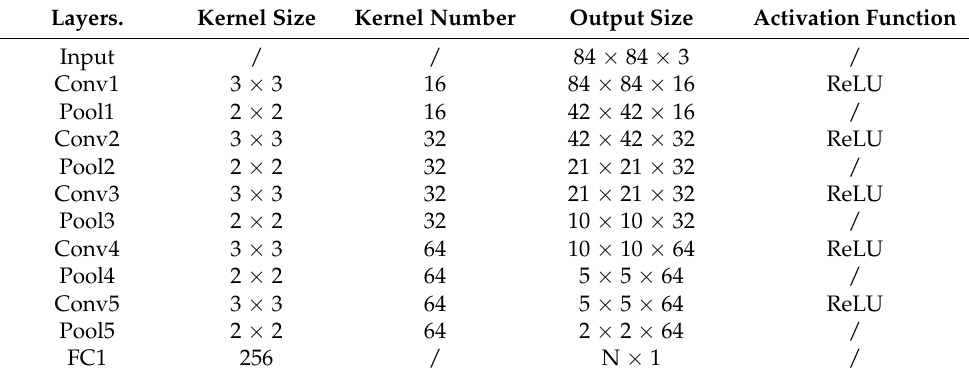
Table 1. Parameters of the proposed Conv5 architecture. Layers.